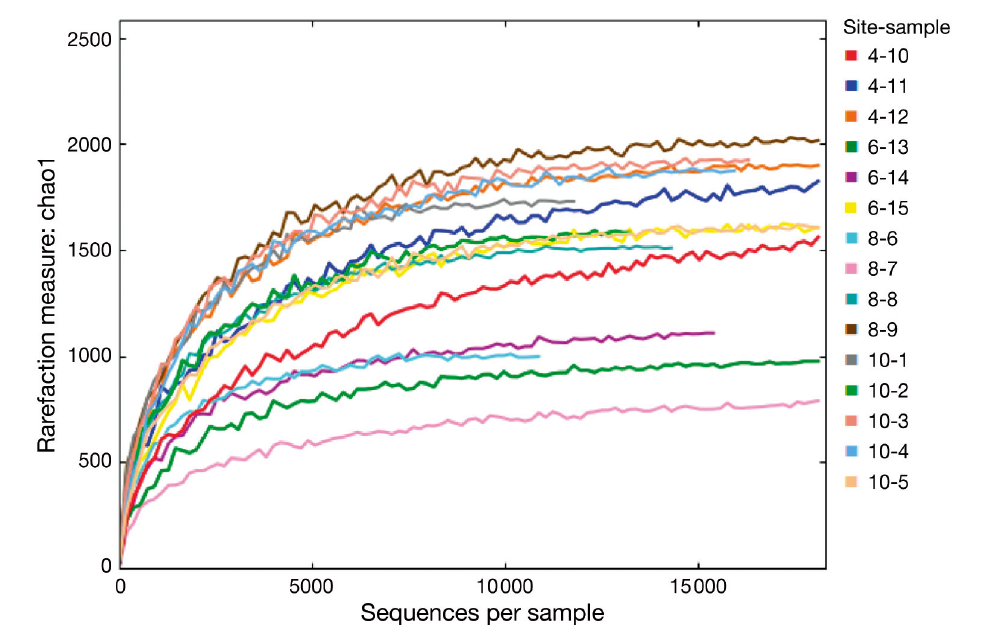
Fig. A1. Rarefaction curves of samples. Shown are individual samples along with the corresponding fraction sampled and calculated Chao1 rarefaction